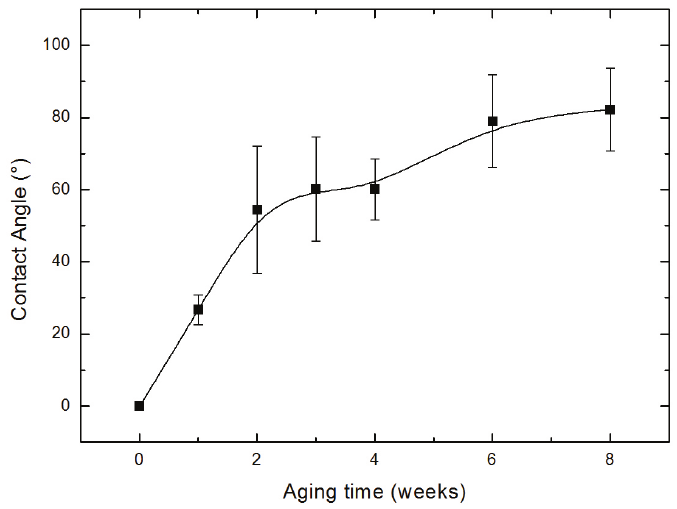
Figure 5. Contact angle of the coatings as a function of aging time.